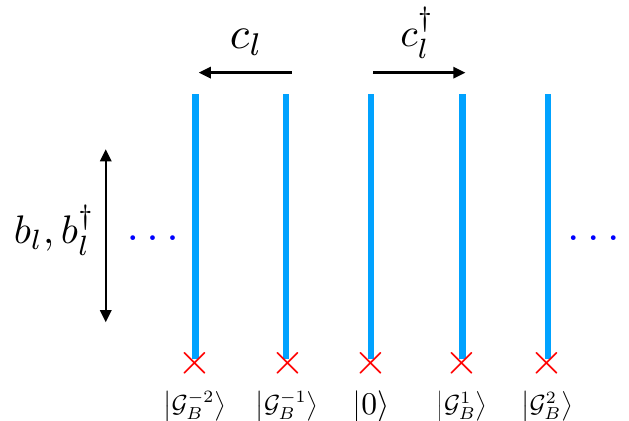
Figure 1. The base manifold is made of all the bosonic ground states which are denoted as the G B red crosses. The vertical blue lines are modules of the fermionic fock space where each represents a bosonic Hilbert space with (cid:12)xed fermion number. The operators of bosonic type can only move vertically while the fermionic ones span the whole Fock space with a single fermionic operator moving